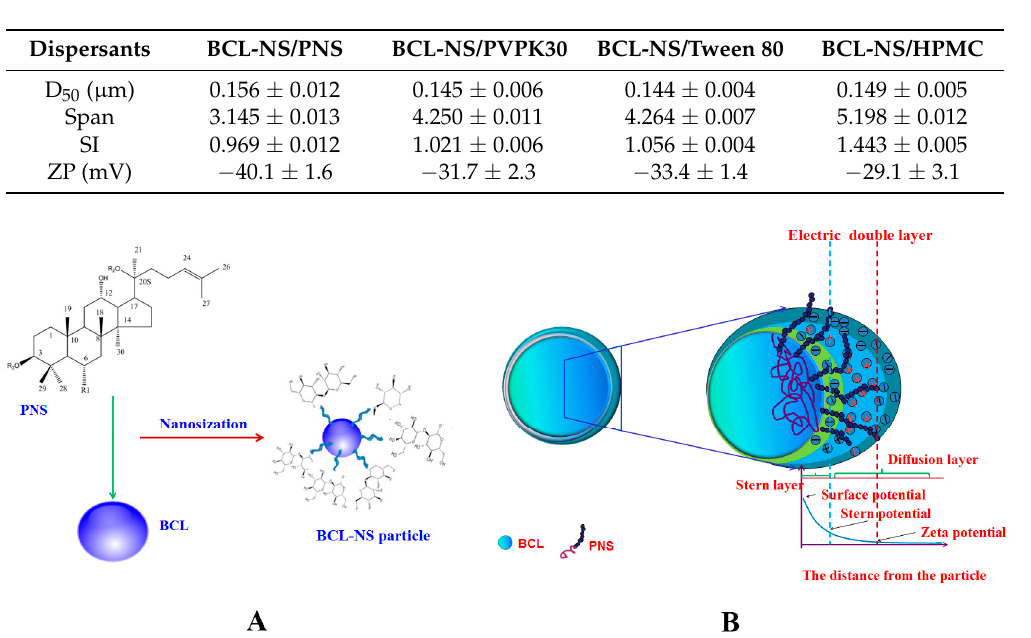
Table 1. Characterization of freshly prepared baicalein nanocrystals suspension (BCL-NS) stabilized by different stabilizers (mean ± S.D., n = 3).